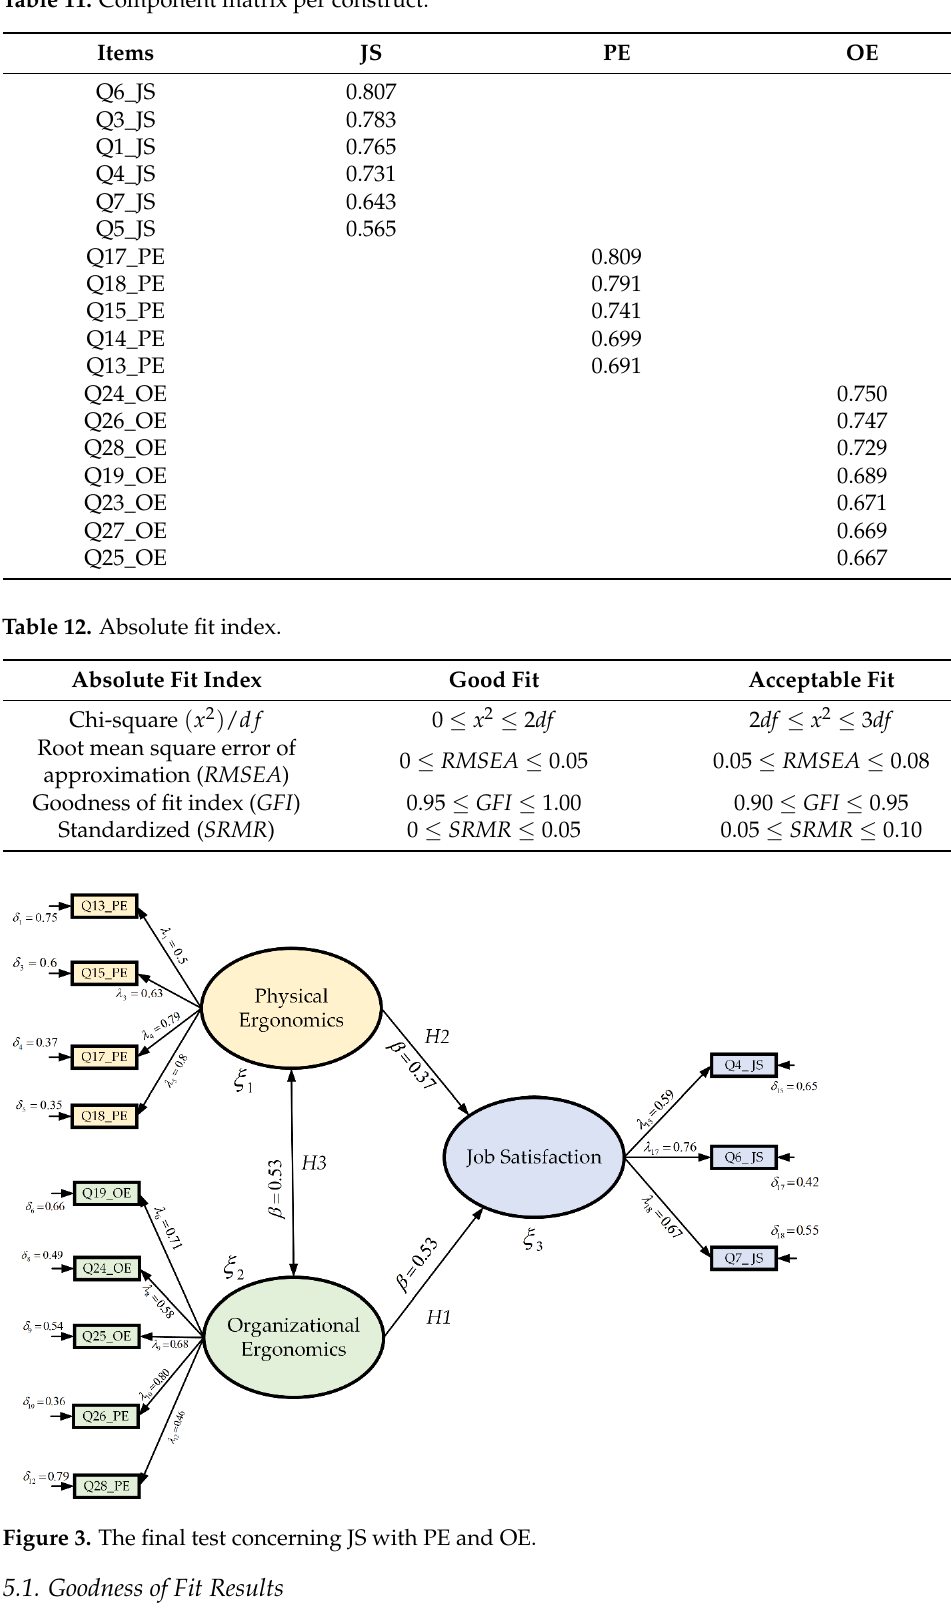
Table 13. Model regression coefficients. Model Regression Coefficients